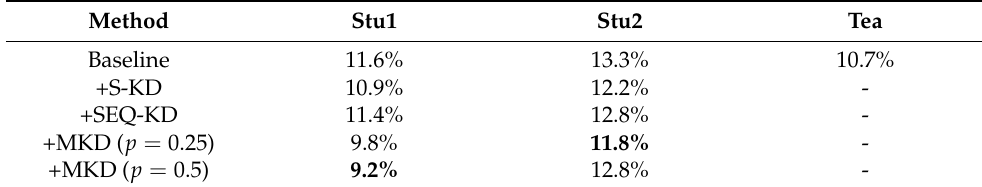
Table 3. The CER of proposed MKD on Aishell-1.